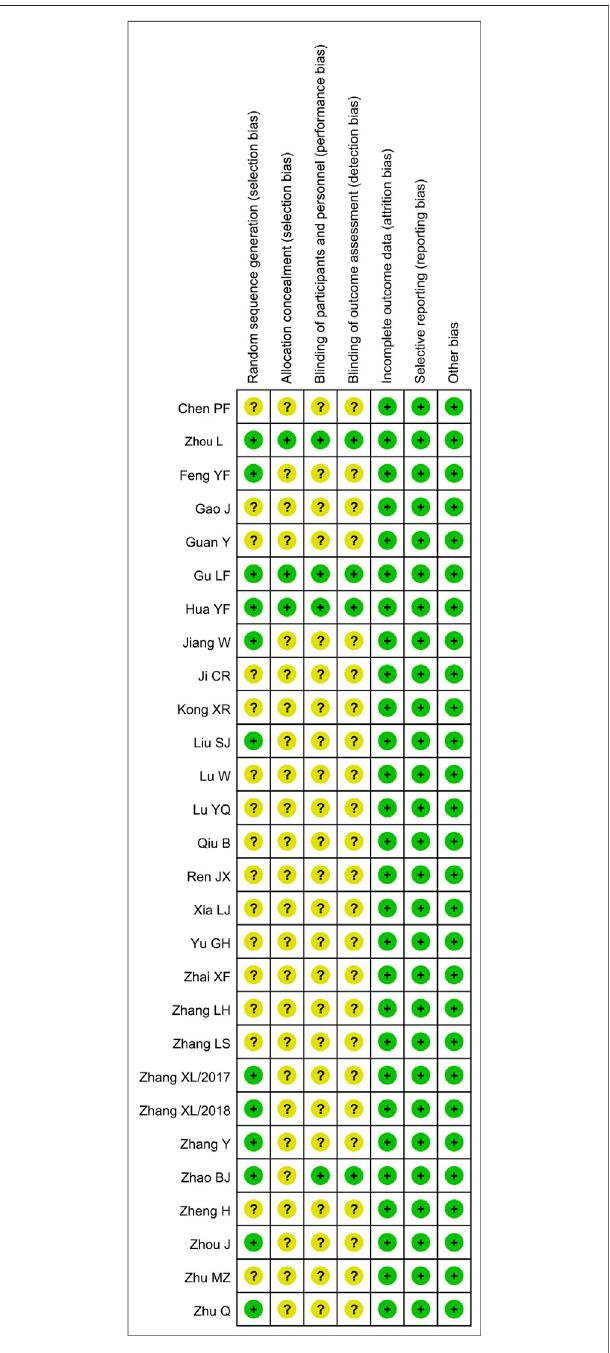
FIGURE 2 | Quality evaluation of included